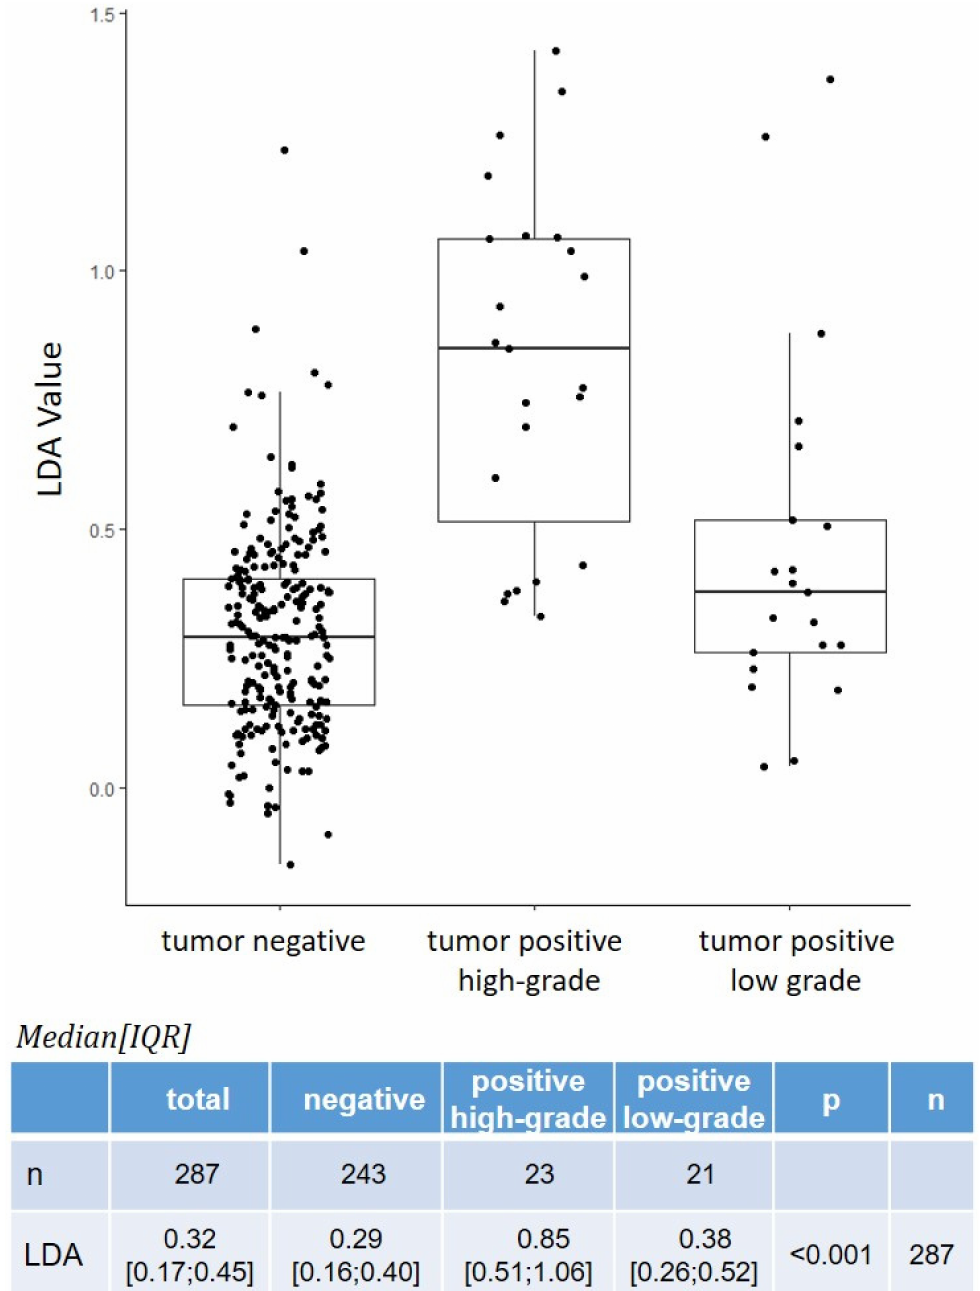
Figure 2. Boxplot of XBCM LDA values for tumor positive high-grade and low-grade